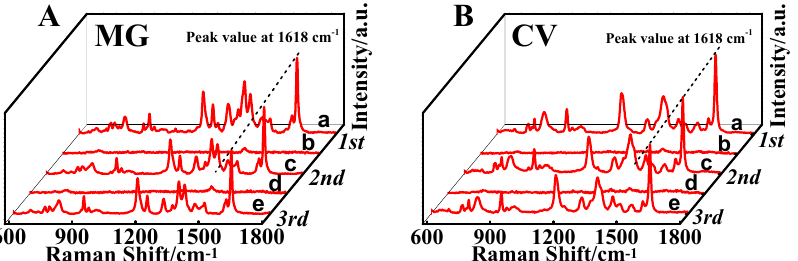
8 of 11 Figure 4. SERS detections of MG and CV on Au NRs@TiO 2 substrates, respectively. ( A ) The Raman spectrum of MG at different concentrations, from 0 to 100.0 μ g/L (a-h), and the insert was from 0 to 10.0 μ g/L (a-d). ( B ) Calibration plots for quantitative detection of MG were from 0.75 to 100.0 μ g/L. ( C ) The Raman spectrum of CV at different concentrations, from 0 to 100.0 μ g/L (a-i), and the insert was from 0 to 5.0 μ g/L (a-d). ( D ) Calibrations plot for quan- titative detection of CV were from 0.50 to 100.0 μ g/L . Next, 10.0 μ g/L MG and 5.0 μ g/L CV adsorbed on Au NRs@TiO 2 substrates were investigated under UV irradiation. As can be seen in Figure 5A,B, the SERS